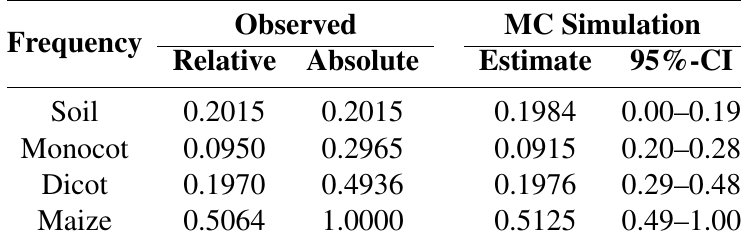
Table 3. Observed and simulated Monte Carlo occurrence of monocots, dicots, crop and soil, including 95%-confidence intervals